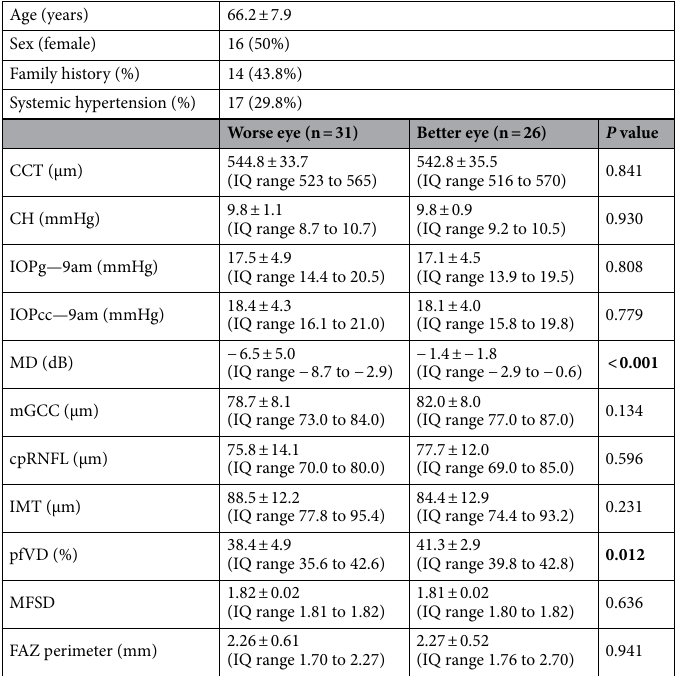
Table 1. Demographic and clinical characteristics of patients with normal tension glaucoma included in the study. Values with a P -value < 0.05 are highlighted in